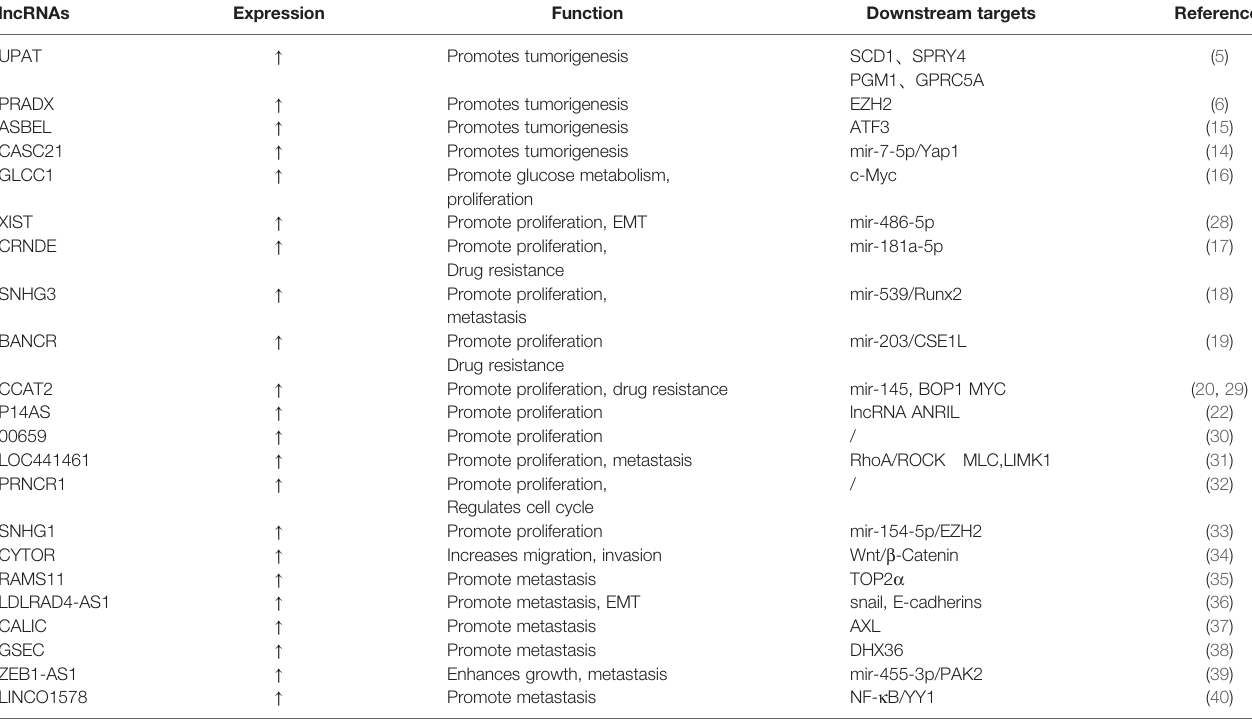
TABLE 1 | LncRNAs in the occurrence, proliferation, invasion, and metastasis of CRC